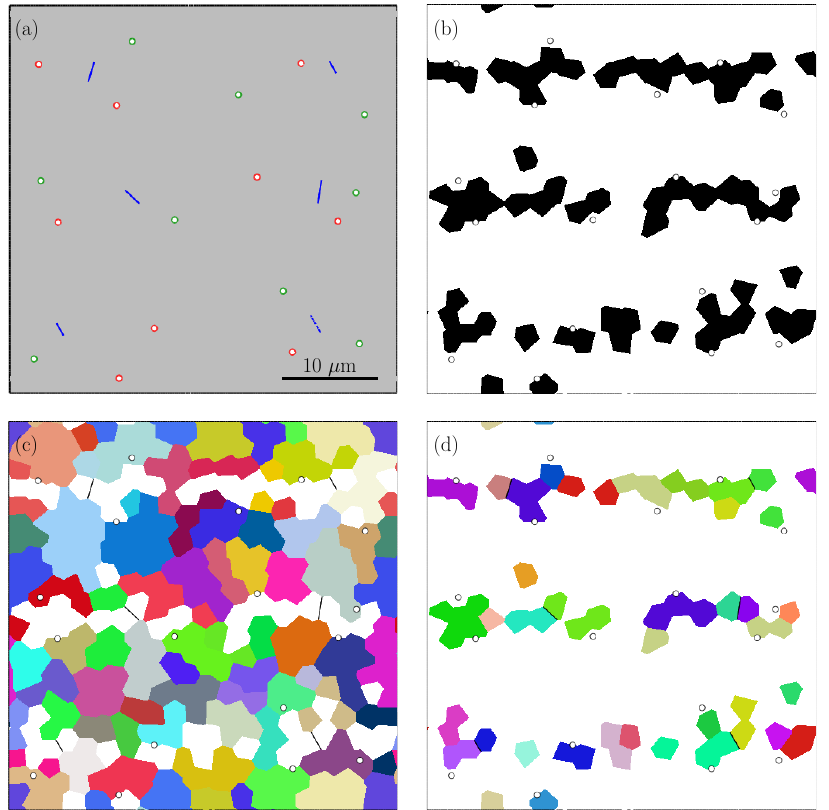
Figure 2. RVE with banded morphology, ( a ) voids (green: voids in ferrite, red: voids at the ferrite–martensite boundary) and cracks (blue), ( b ) ferrite (white) and martensite (black), ( c ) colors indicate 69 ferrite orientations, ( d ) colors indicate 29 martensite